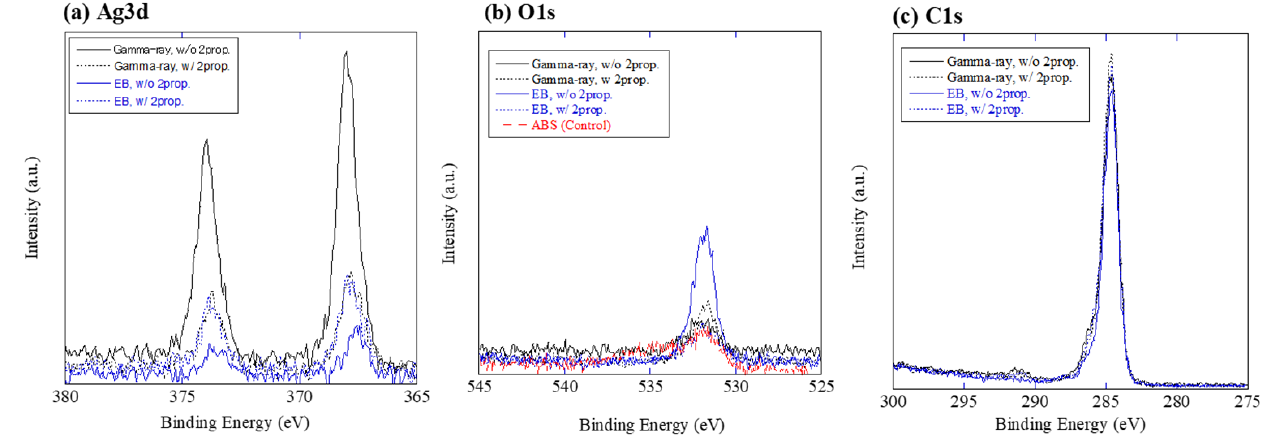
Figure 2. XPS spectra of ( a ) Ag3d, ( b ) C1s and ( c ) O1s for Ag/ABS samples. Table 1. Peak positions of the Ag3d-, C1s- and O1s-XPS spectra for Ag/ABS samples. Sample ID Gamma ray, without 2-prop. Gamma ray, with 2-prop. (10% vol.) Electron Beam, without 2-prop. Electron Beam, with 2-prop. (10% vol.)